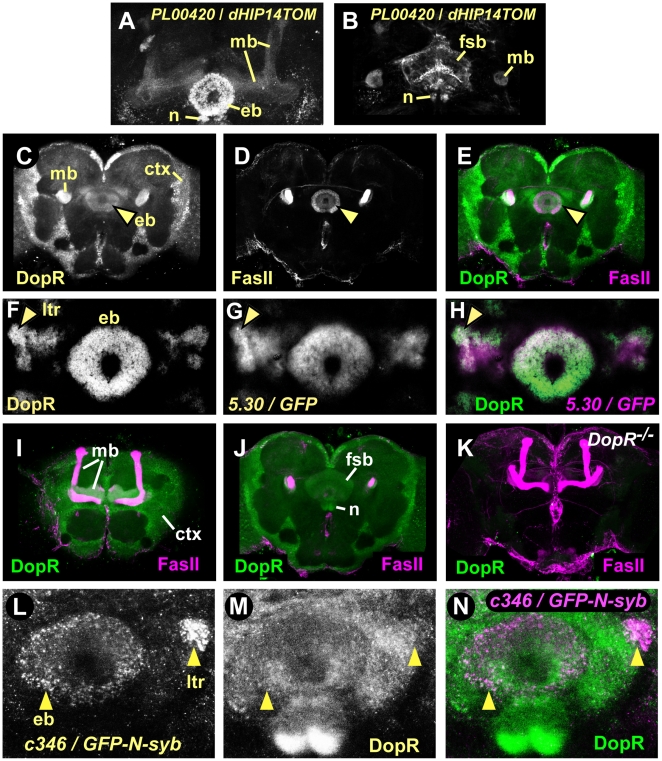
The D1-like DA receptor DopR expression pattern in the adult brain includes the R neurons of the central complex ellipsoid body.
A–B. Presynaptic regions of DopR-expressing neurons. GAL4 enhancer trap PL00420 in the DopR locus driving expression of tdTomato-GFP tagged with presynaptic protein HIP14. A. Expression in the mushroom body lobes (mb), ellipsoid body neurons (eb), and central complex noduli (n). B. Expression in the central complex fan shaped body (fsb) and noduli, and the mushroom body peduncles. C–E. Genetic background control brains stained with DopR (green) and FasII (magenta) antisera. Each panel is a 4.3 µm confocal section of a whole mount brain. Ellipsoid body (arrowhead), mushroom body peduncles, and cellular cortex (ctx) labeling with DopR antisera. F–H. Ellipsoid body lateral triangles (arrowhead) and ring showed elevated DopR levels that were coincident with the 5.30 GAL4 enhancer trap expression pattern in 10 µm thin sections. I. Mushroom bodies and cellular cortex staining in controls. J. Fan-shaped body and noduli DopR staining in controls. K. DopRf02676 mutant brain (DopR−/−) stained with DopR (green) and FasII (magenta) antisera. 100 µm confocal projection shows nearly absent DopR staining throughout the brain. L–N. Colabeling of c346 presynaptic sites (using n-syb-tagged GFP) and DopR in the ring and lateral triangles.